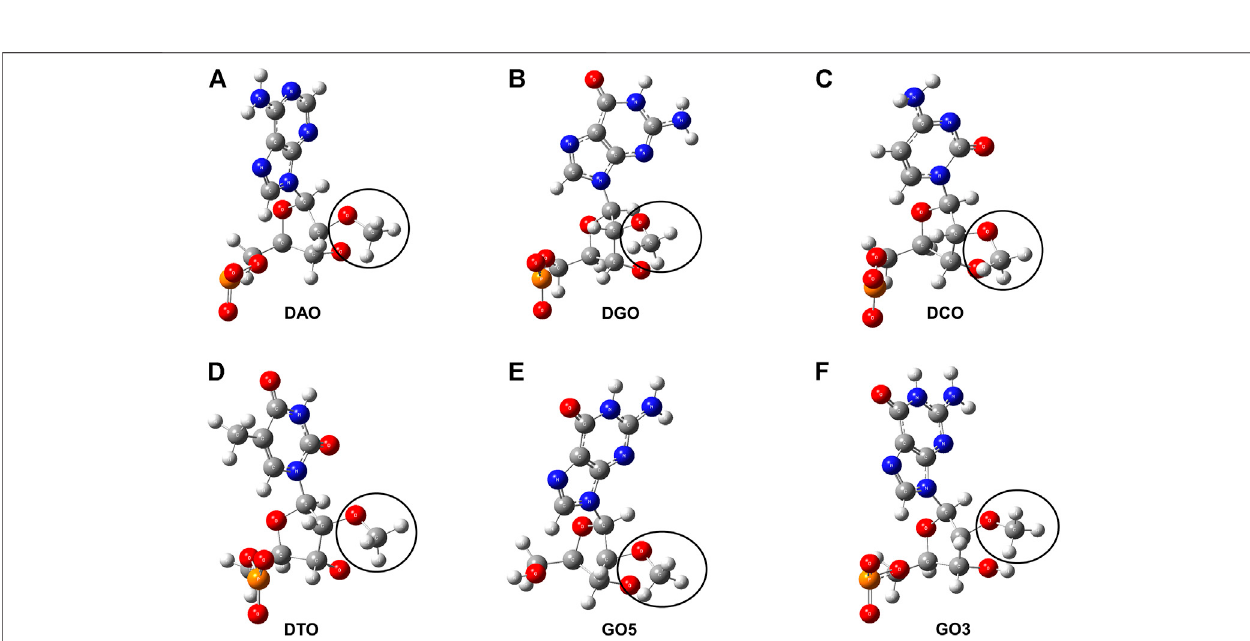
FIGURE3 | Structure charts ofsix non-standard nucleotides. (A) 2 ′ -O-methyl-deoxyadenosine (DAO). (B) 2 ′ -O-methyl-deoxyguanosine(DGO). (C) 2 ′ -O-methyl- deoxycytidine (DCO). (D) 2 ′ -O-methyl-deoxythymidine (DTO). (E) 5 ′ -deoxyguanosine modi fi ed with -OCH 3 group (GO5). (F) 3 ′ -deoxyguanosine modi fi ed with -OCH 3 group (GO3). The segments circled by the black curve are all the -OCH 3 group.